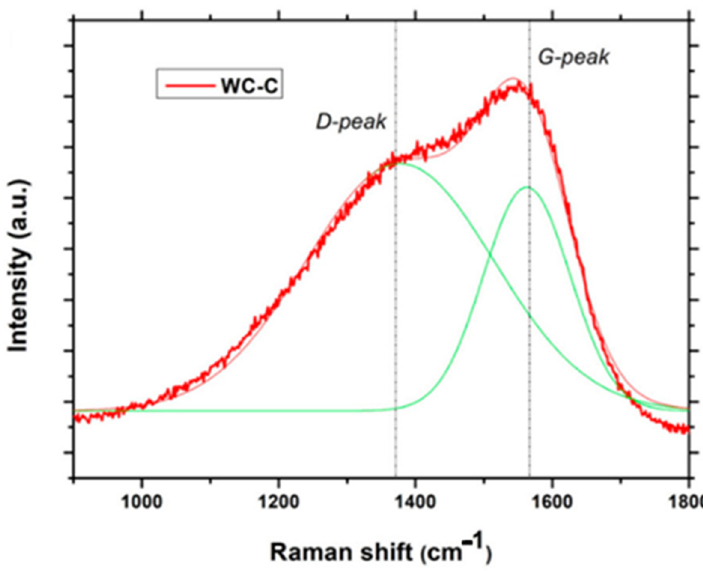
Figure 5. Raman spectrum of WC:C